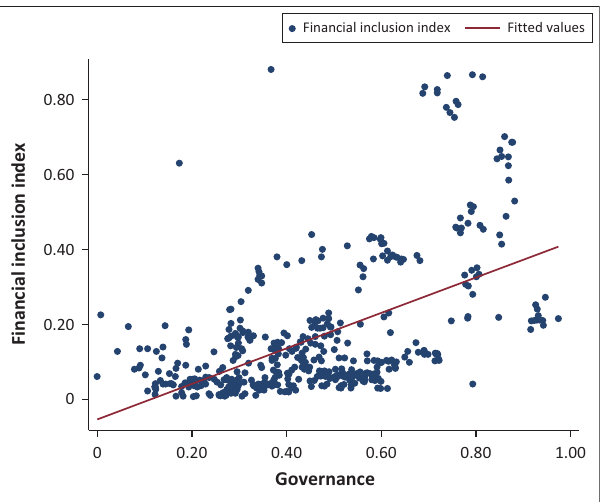
FIGURE 3: Institutional governance.